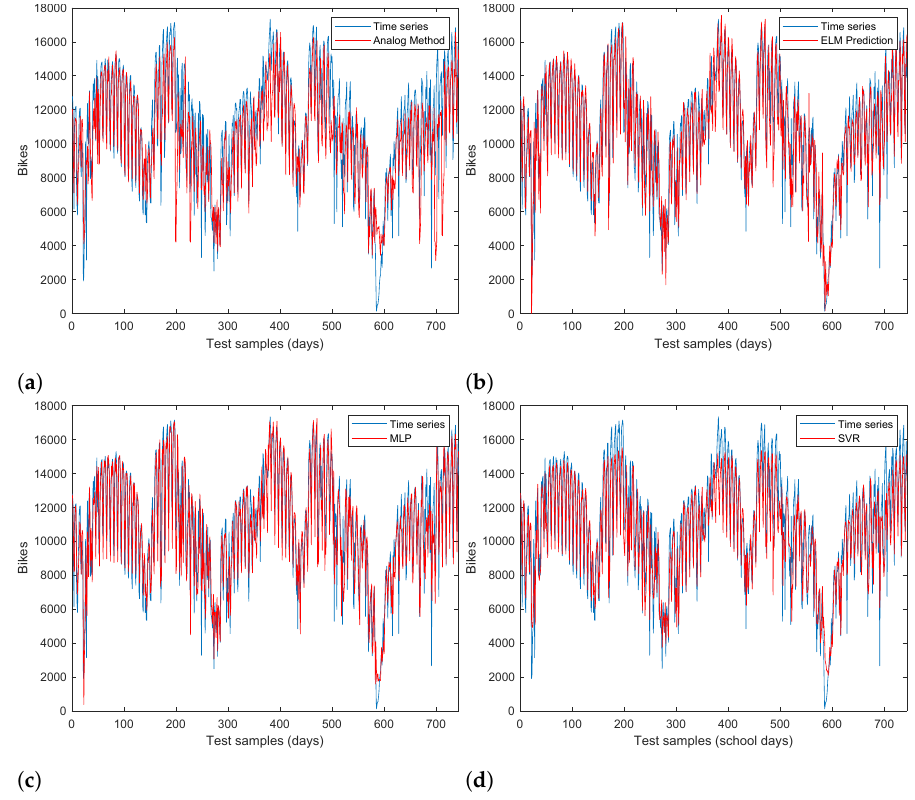
Figure 5. Performance of the different regressors considered in the bike sharing demand prediction problem in Madrid. ( a ) ANA; ( b ) ELM; ( c ) MLP; ( d ) SVR. problem in Madrid. ( a ) ANA; ( b ) ELM; ( c ) MLP; ( d ) SVR. Except ANA method, all other methods predict well the bike demand time series. Except the ANA method, all other methods predict the bike demand time series